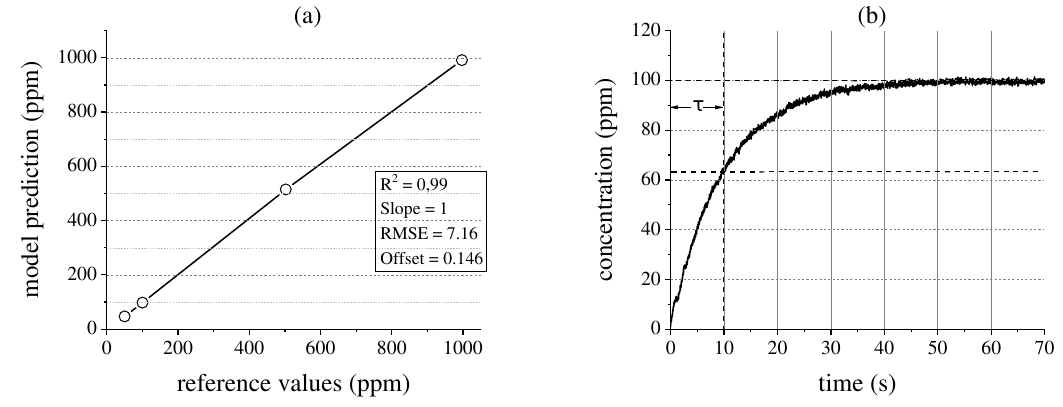
Figure 5. ( a ) Validation plot of the partial least squares (PLS) model applied to the measured absorption spectra; ( b ) Gas concentration increase in the system over time when measuring a 100 ppm R134a probe at a volume flow rate of 1 L min − 1